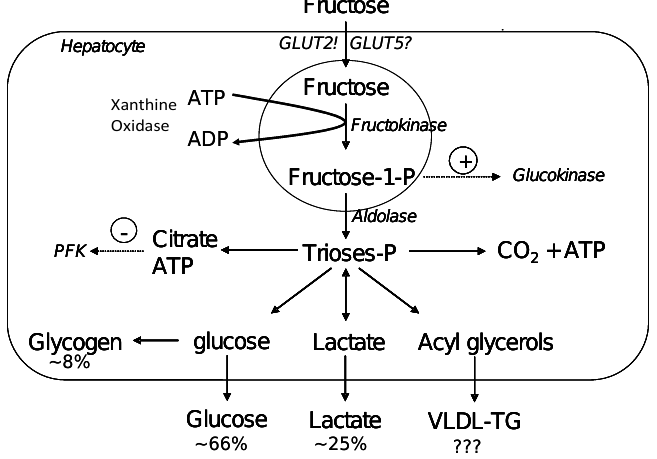
Figure 1. Metabolic fate of hepatic fructose. Fructose provides a high concentration of unregulated acetyl-CoA which can be converted to very-low density lipoprotein-triglyceride (VLDL-TG), glucose and/or lactate. (Figure adapted from Le and Tappy, 2006 [13]). GLUT: glucose transporter; PFK: phosphofructokinase.